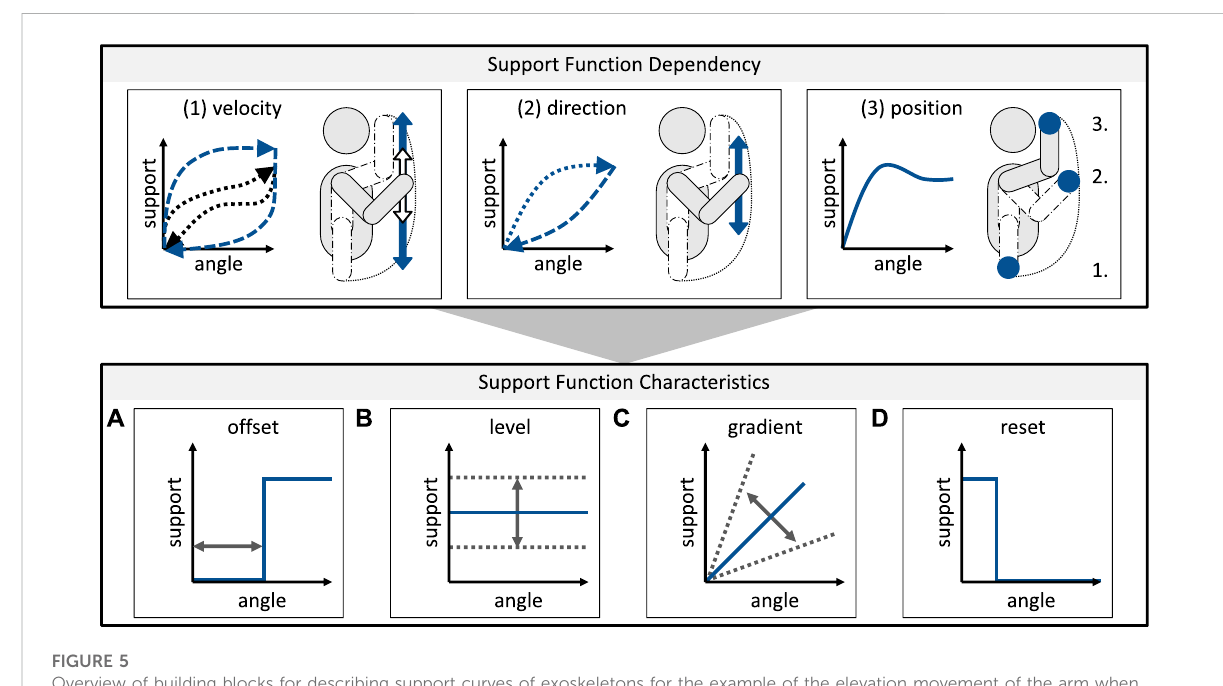
FIGURE 5 Overview of building blocks for describing support curves of exoskeletons for the example of the elevation movement of the arm when performing assembly activities above head